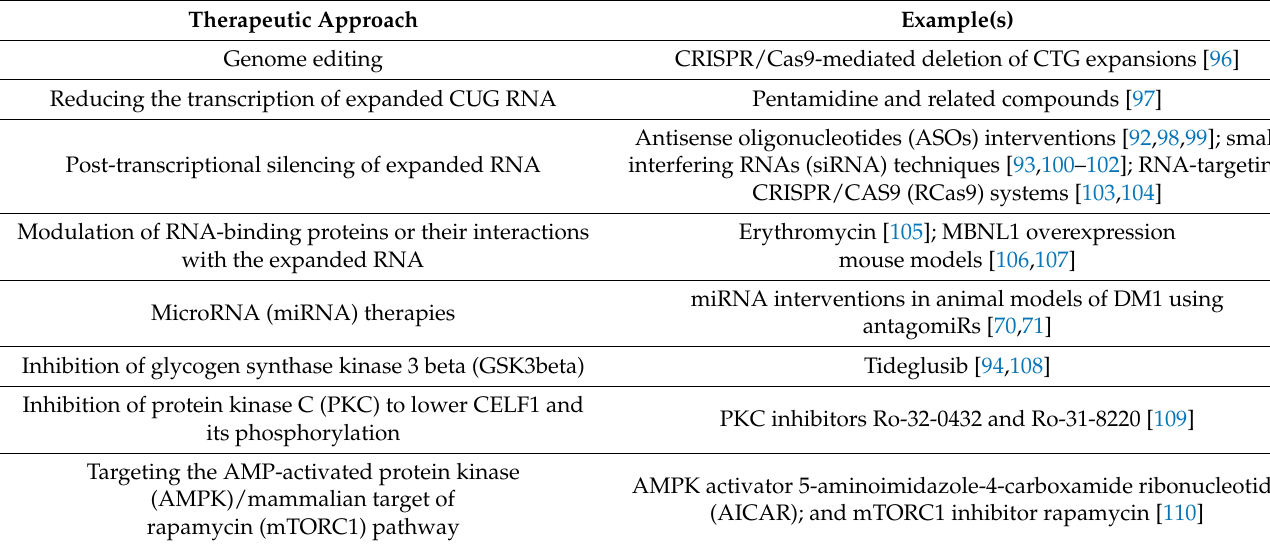
Table 5. Therapeutic approaches in myotonic